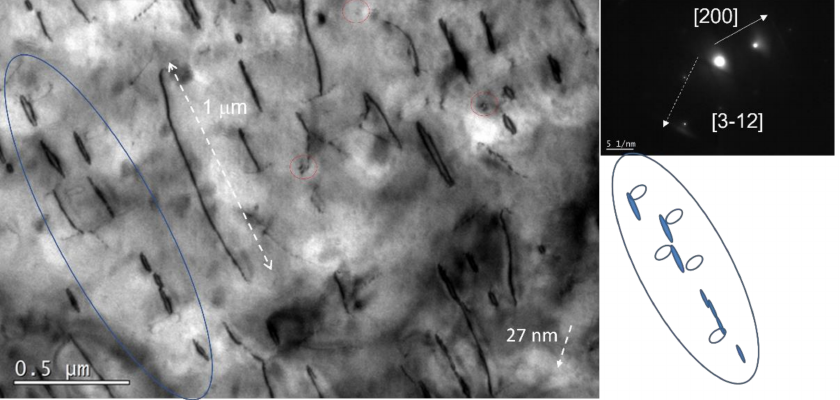
Figure 16. TEM micrograph from the Fe sample irradiated at HD and 300 ◦ C with Fe +4 at 20 MeV.